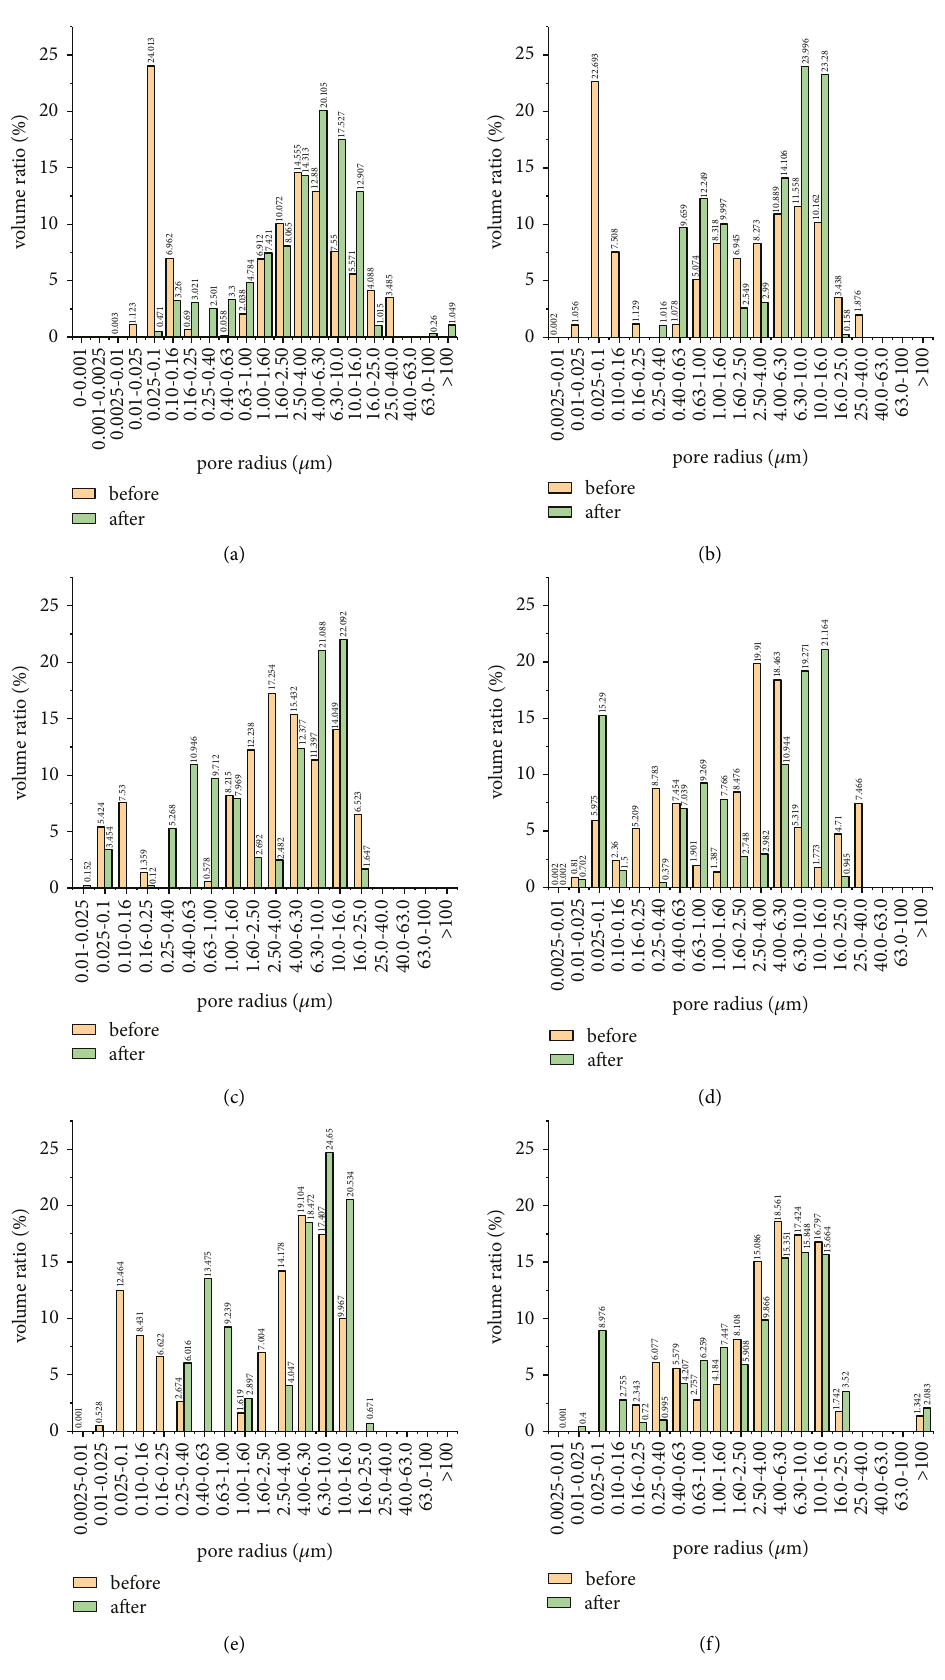
Figure 4: Pore size distribution before and after vibration at different amplitudes: (a) 50%, (b) 60%, (c) 70%, (d) 80%, (e) 90%, (f)